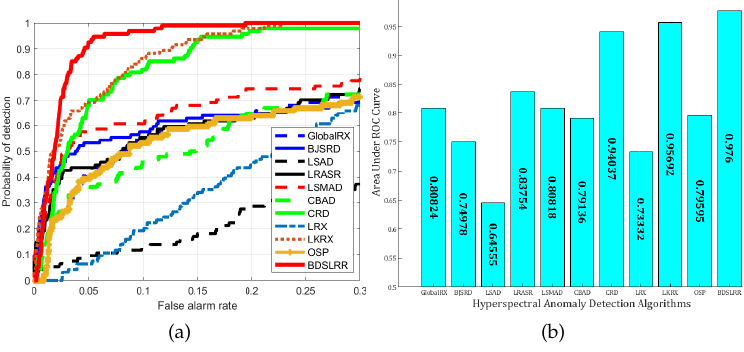
Figure 14. Detection accuracy evaluation for the San Diego dataset. ( a ) ROC curves; ( b ) AUC values.